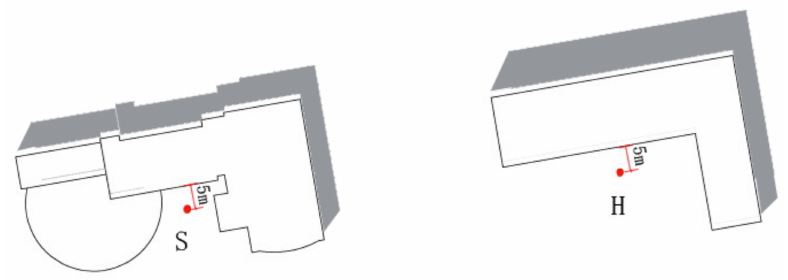
Figure 15. Measuring points S and H.